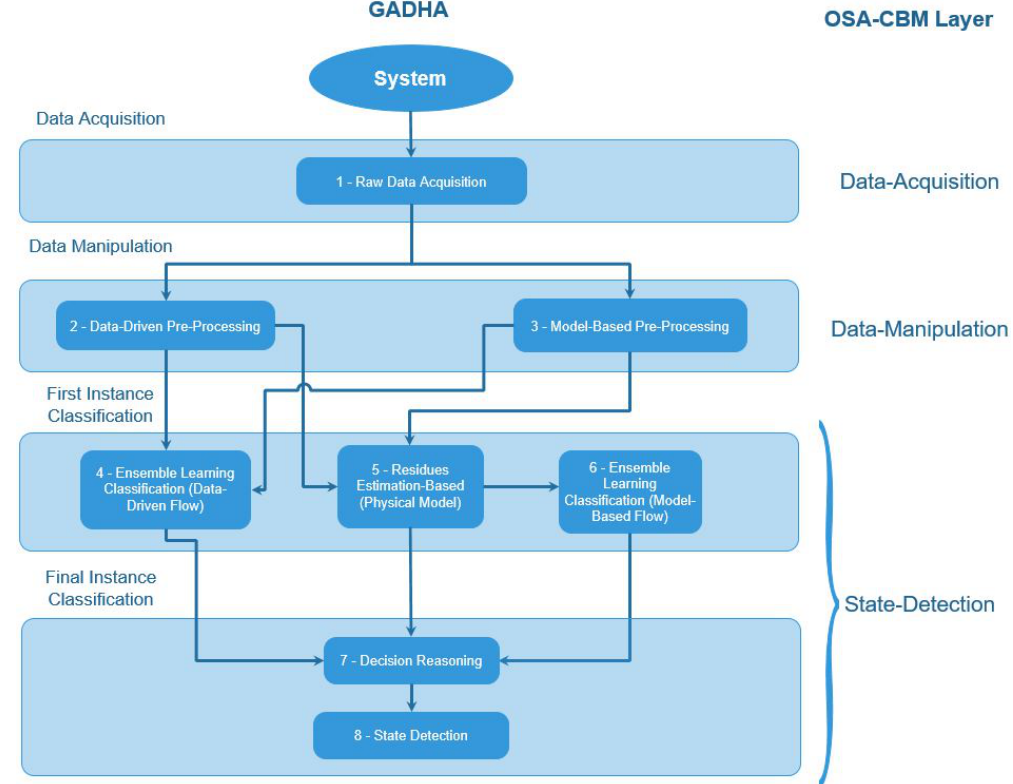
Figure 2. Generic Anomaly Detection Hybridization Algorithm (GADHA)